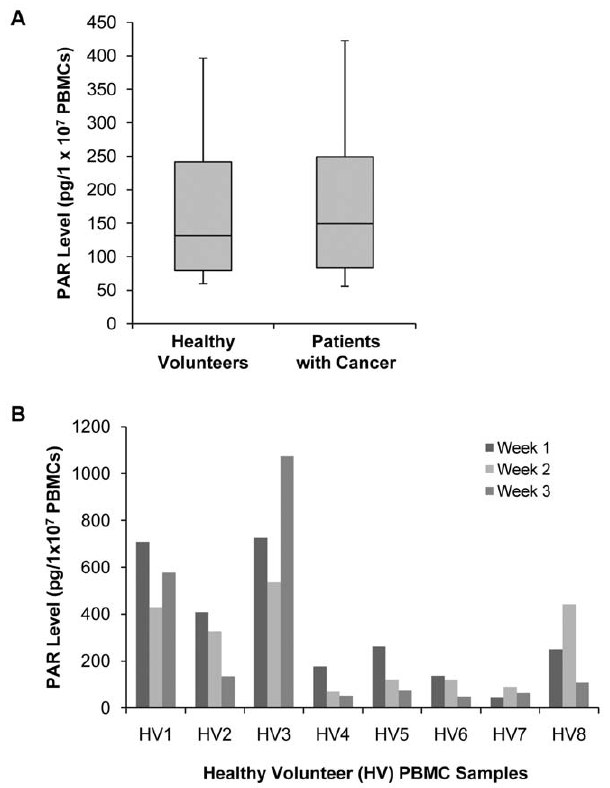
Figure 2. Baseline PAR levels in PBMCs from healthy volunteers and patients with cancer. (A) PAR levels in PBMC samples from 135 healthy volunteers and 47 patients with cancer. Box plot represents the interquartile range with median indicated; whiskers represent the 10 th and 90 th percentile. (B) PAR levels in PBMCs collected from eight healthy volunteers (HV) once per week for 3 consecutive weeks.